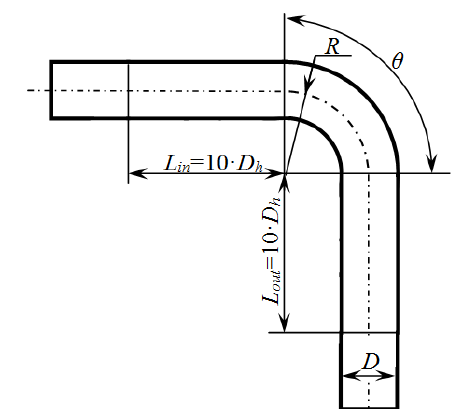
Fig. 5 Model of elbow with inlet and outlet